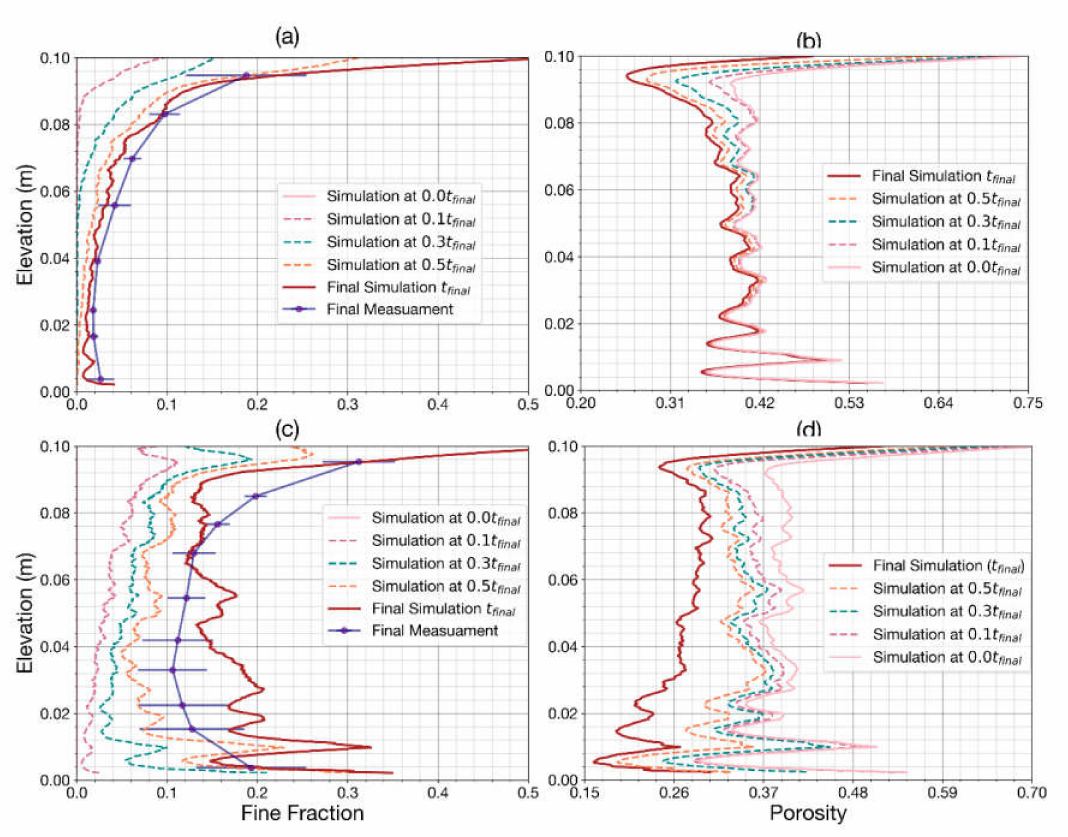
Figure 8. Simulated fine sediment distribution in comparison with measurements [18] (( a ) bridging and ( c ) percolation) and simulated porosity (( b ) bridging and ( d )